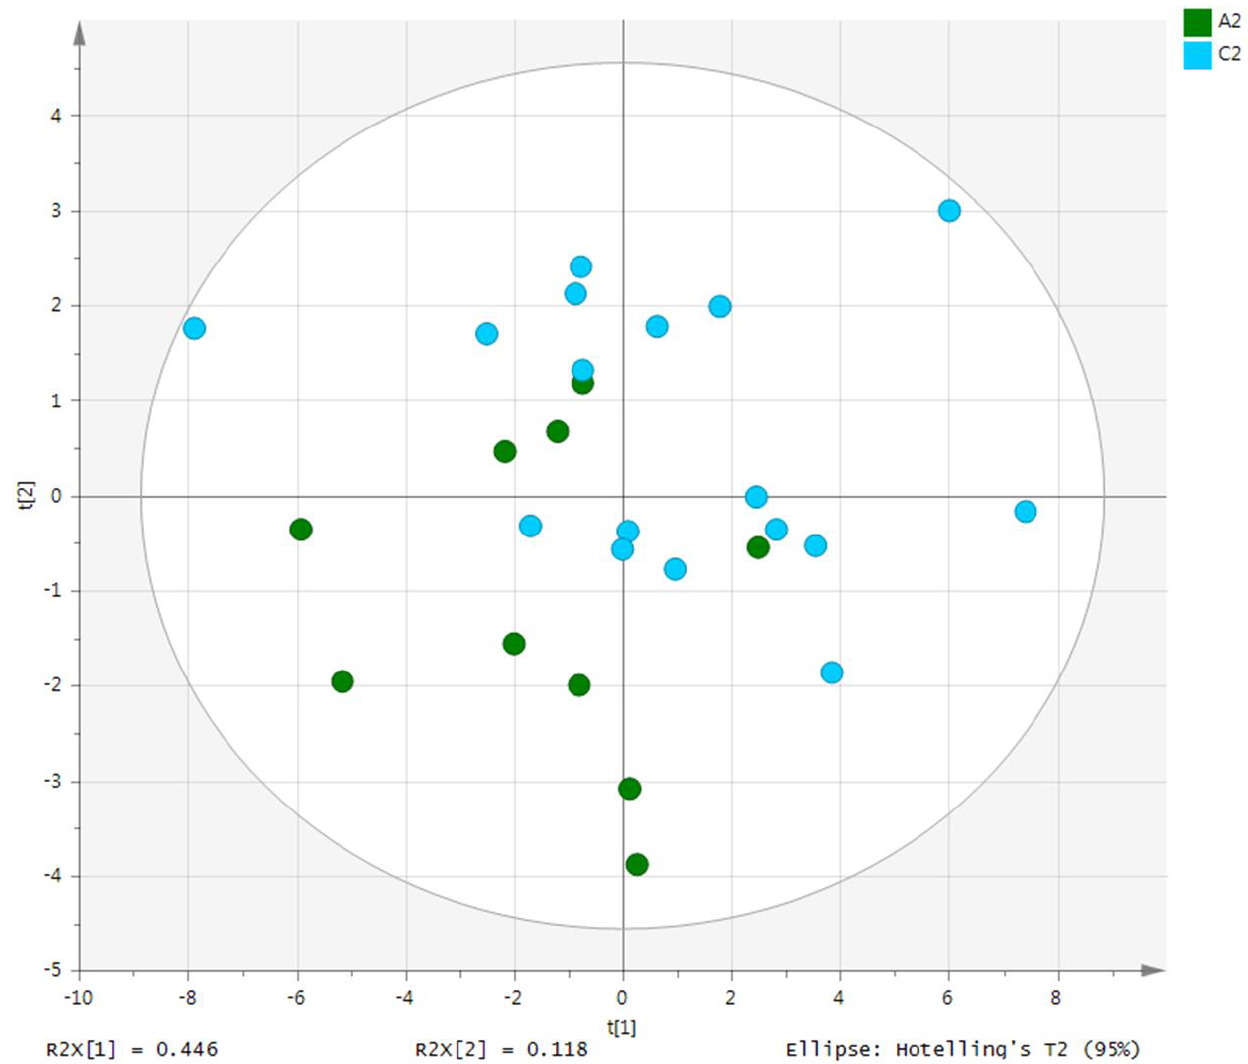
Figure 1. PCA score plot derived from the 1H-NMR spectra of serum from the ulcerative colitis (UC) patient group ( n = 10) and healthy control (HC) group ( n = 10). PCA, principal component analysis; NMR, nuclear magnetic resonance; A2, ulcerative colitis group; C2, healthy control group.